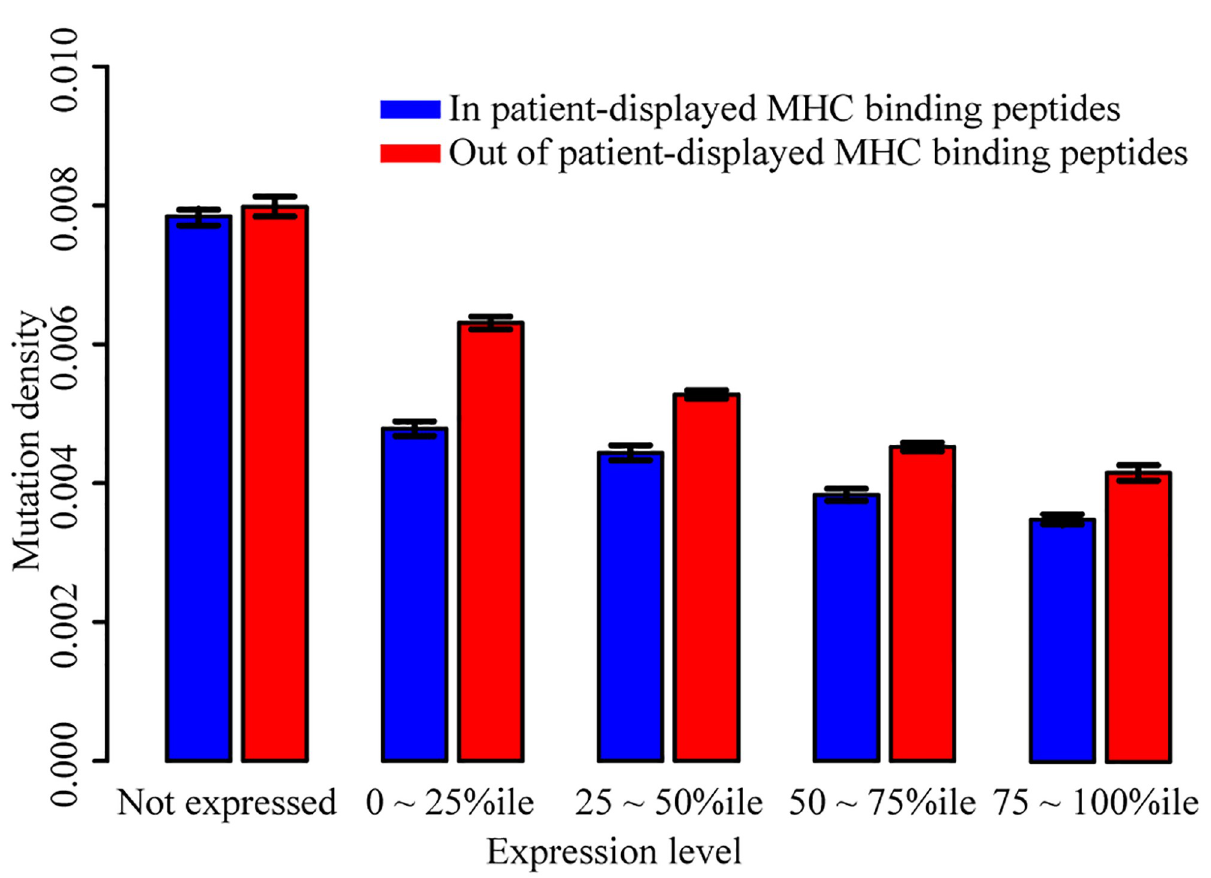
Fig 2. MHC-display-dependent mutation densities for genes with different expression levels, considering each patient’s HLA type. Blue bars are the mutation density within the predicted patient-displayed MHC binding peptides. Red bars are the mutation density out of the patient-displayed predicted MHC binding peptides. Mutations were separated into five categories based on the expression levels of their